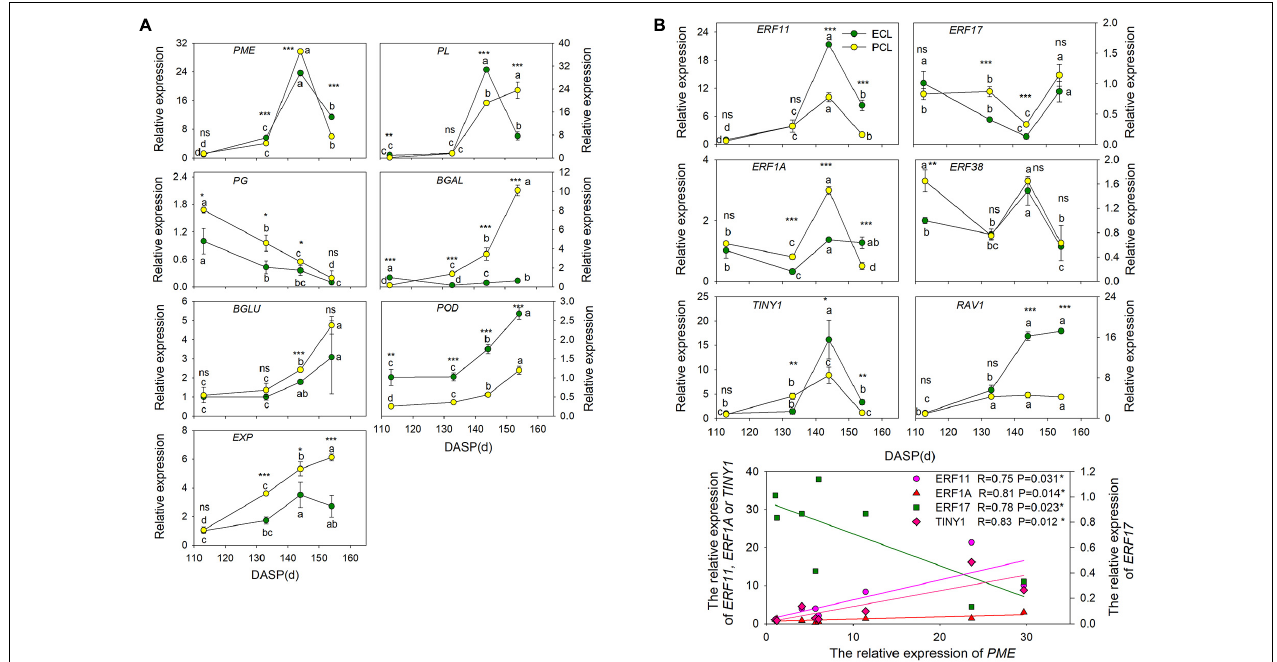
FIGURE 6 | Changes in the expression of the cell wall modification-relevant genes and ethylene signal transcription factors of epidermal and parenchymatous cell layers in T. grandis during nut maturation. (A) Quantitative real-time PCR (RT-qPCR) of some cell wall modification-relevant genes. (B) Quantitative real-time PCR (RT-qPCR) of ethylene signal transcription factors selected by co-expression analysis. ECL, epidermal cell layer; PCL, parenchymatous cell layer. The expression levels were calculated relative to corresponding values at 113 DASP. Error bars represent standard error base on three biological replicates. Different lowercase letters indicate a significant difference at different growth stages ( P < 0.05) by Duncan’s multiple range test. Asterisks denote significant differences using independent-samples t -test: * P < 0.05, ** P < 0.01, *** P < 0.001, ns P > 0.05. The solid line represents the best-fit linear regressions between PME and four ethylene signal transcription factors: * P < 0.05. N =